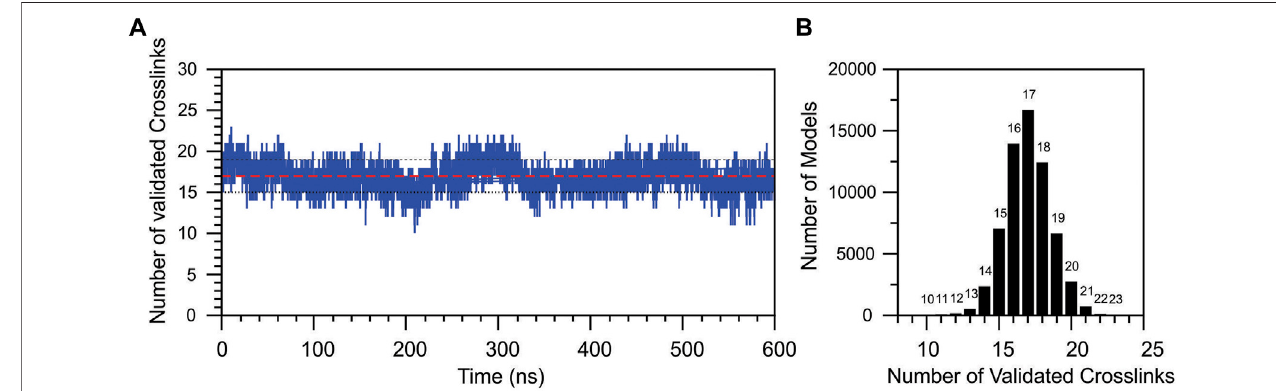
FIGURE 9 | Topological validation of all cross-linking results during the molecular dynamics simulation of DM46-myotoxin II complex. (A) The number of validated cross-links was plotted as a function of the MD simulation time. The traced red line represents the average validation, and the black dotted lines represent the average fl uctuation. (B) The total number of models produced in the MD simulation as a function of the number of validated cross-links.